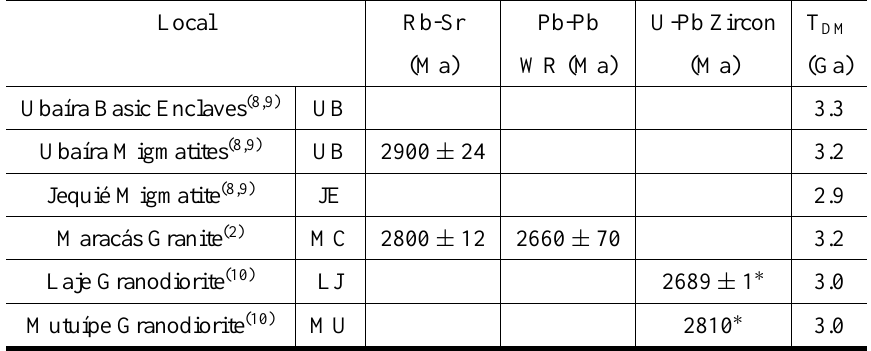
Jequié Block. Ages of theArchean main plutonic rocks according to different radiometric methods. Marinho (1991) (2), Wilson (1987) (8), Marinho et al. (1994) (9), Alibert & Barbosa (1992) (10). Asterisks represent SHRIMP data. WR = Whole Rock.